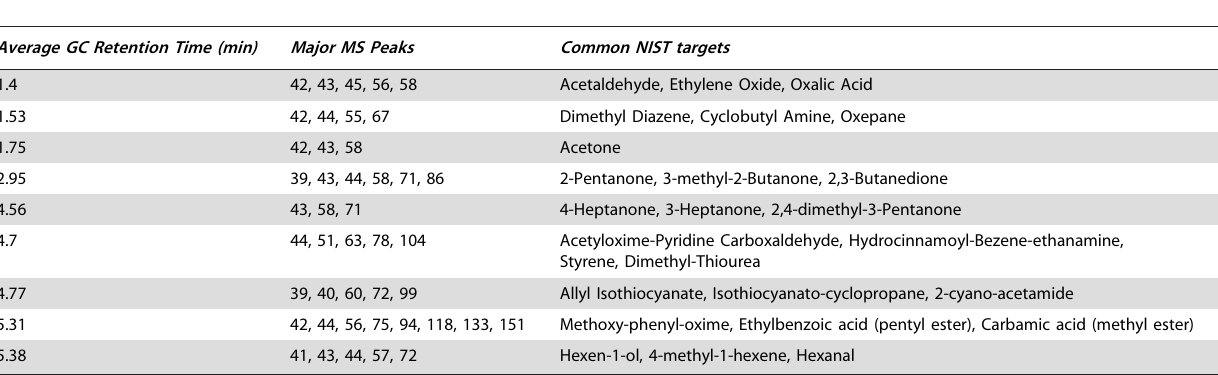
Table 3. GC-MS peaks for the CRC patients and corresponding National Institute of Standards and Technology (NIST) targets for these